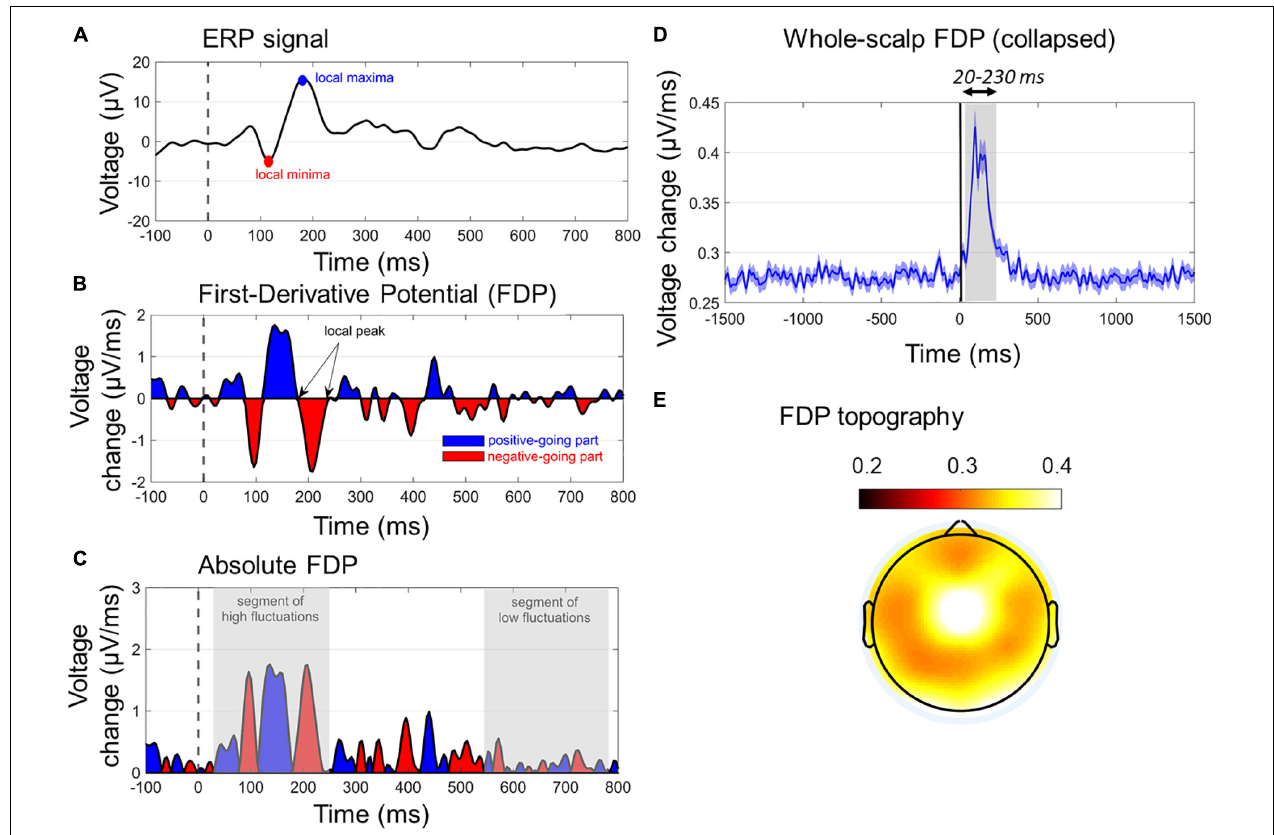
FIGURE 4 | Characteristics of first-derivative potentials (FDPs). (A) A typical ERP wave with two dominant early peaks. (B) The respective FDP curve of ERP, indicating the peaks (zero values), positive-going (blue segments), and negative-going (red segments) of ERP. The temporal differentiation has been derived with (cid:49) t = 4 ms. (C) The absolute FDP curve, highlighting the segments of rapid (early gray-shaded area) and slow (late gray-shaded area) in ERP waveform. (D) The whole-scalp FDP averaged across subjects and conditions. The window of FDP burst (20–230 ms) is also gray-shaded. (E) The topographical map of the grand-average FDP within the window of 20–230